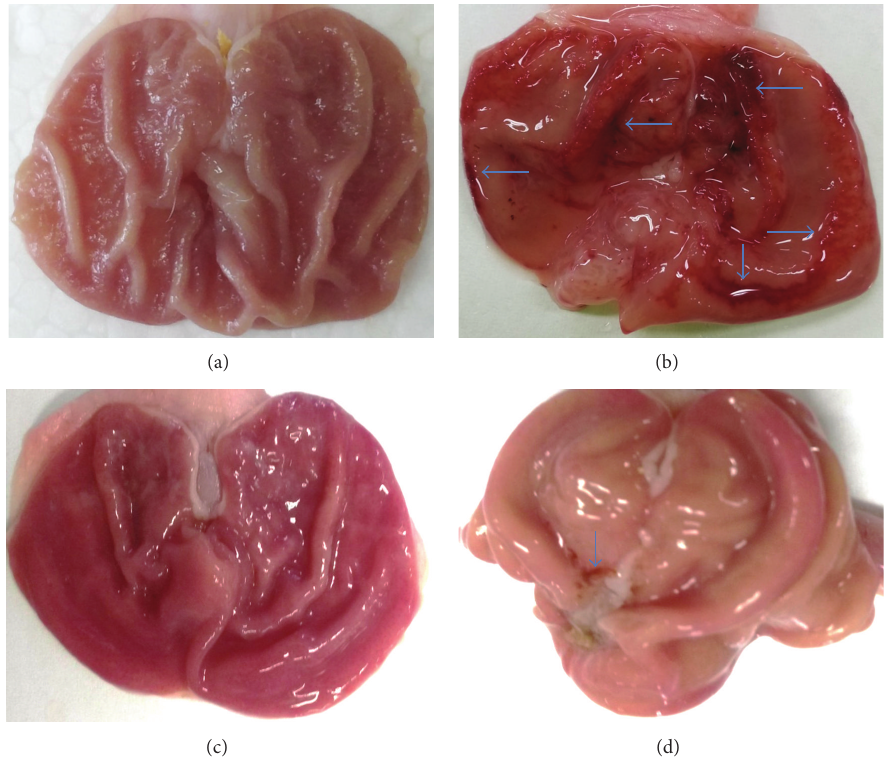
Figure 2: Gastroprotective activity of violacein (40mg/kg) on indomethacin-induced gastric injury in rats. (a) Sham treated rats, (b) vehicle + indomethacin treated rats, (c) violacein (40mg/kg) pretreated rats, and (d) omeprazole (40mg/kg) pretreated rats. Note that indomethacin induced sever injuries to the gastric mucosa that appear as elongated bands of hemorrhage (blue arrow).